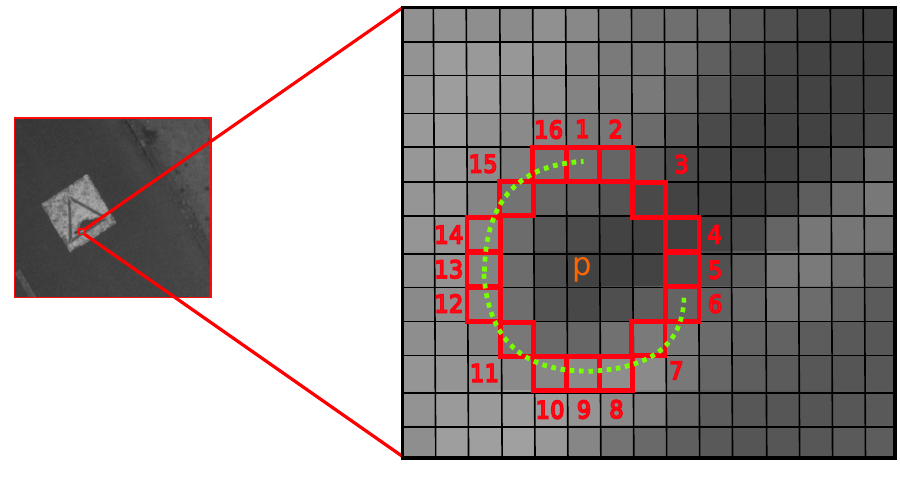
Figure 6. Features from Accelerated Segment Test (FAST)-12 image feature detector